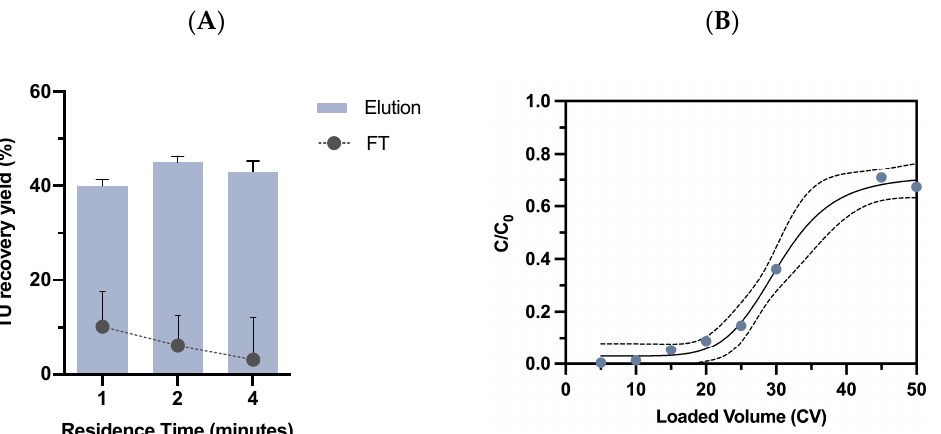
Figure 4. Process parameter optimization for the novel affinity adsorber. ( A ) Comparative VSVG-LVs recovery yield results for different residence times (1, 2, and 4 min). For each condition, the viral recovery and viral loss was estimated. ( B ) Breakthrough curve representation for the Lenti VSVG Affinity Matrix. The clarified VSVG-LVs were loaded at flow velocity of 72 cm/h in a 1 mL packed bed. C is the virus total particles’ concentration in the flow-through samples and C 0 is the virus concentration of feedstock material, the C 0 /C ratio is represented by blue dots. Dashed lines represent the 95% confidence interval. Total particle concentration was estimated by detection of p24 protein.